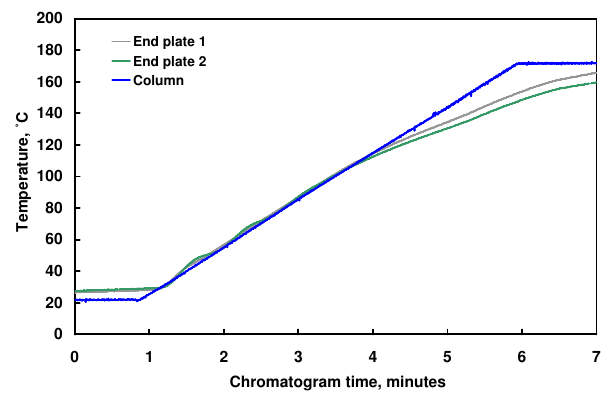
Fig. 3. Performance of the programmed column oven during a lin- ear temperature rise from 20 ◦ C to 175 ◦ C at 30 ◦ Cmin − 1 . The three lines show the simultaneous temperatures of the oven end- plates (grey and green) which provide the bulk of the power and of the column itself (blue) which provides additional regulations from direct